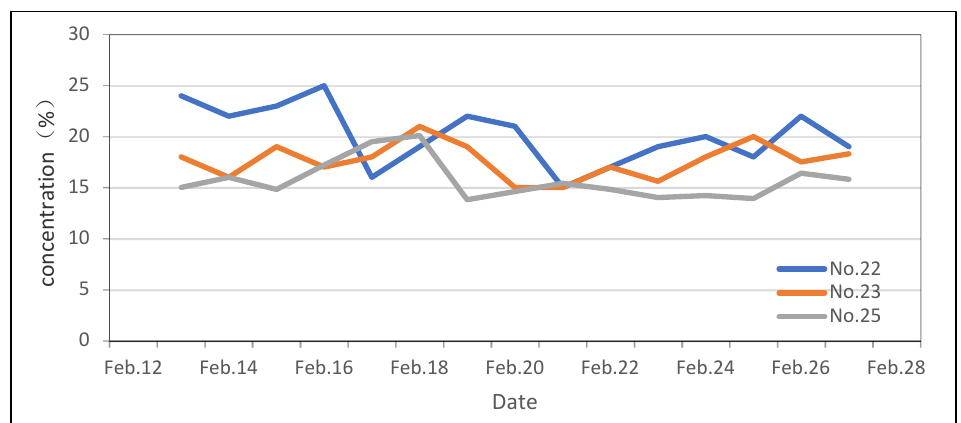
Figure 15. Gas drainage concentration curve of some reverse boreholes.